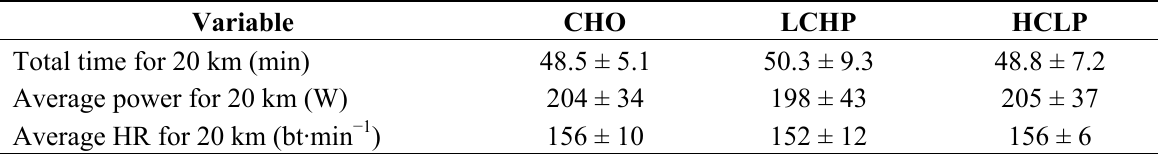
Table 2. Performance Variables during Subsequent Exercise Time-trial (Mean ± SD).